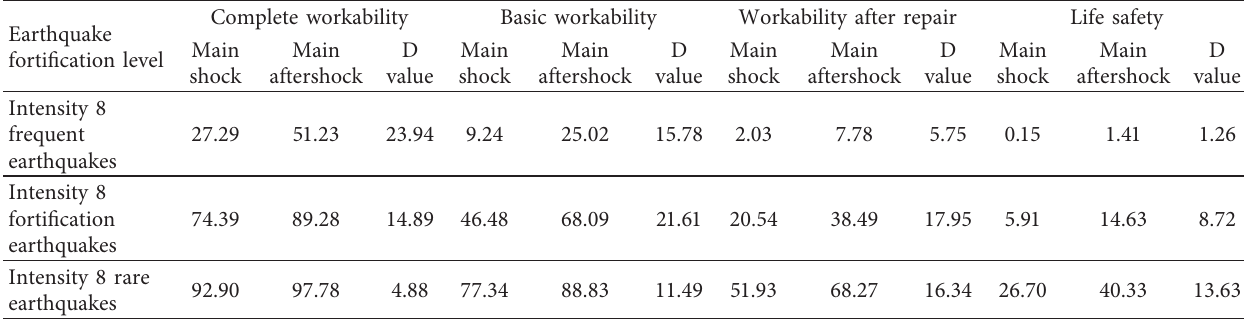
Table 11: Exceeding probability of structural performance level.